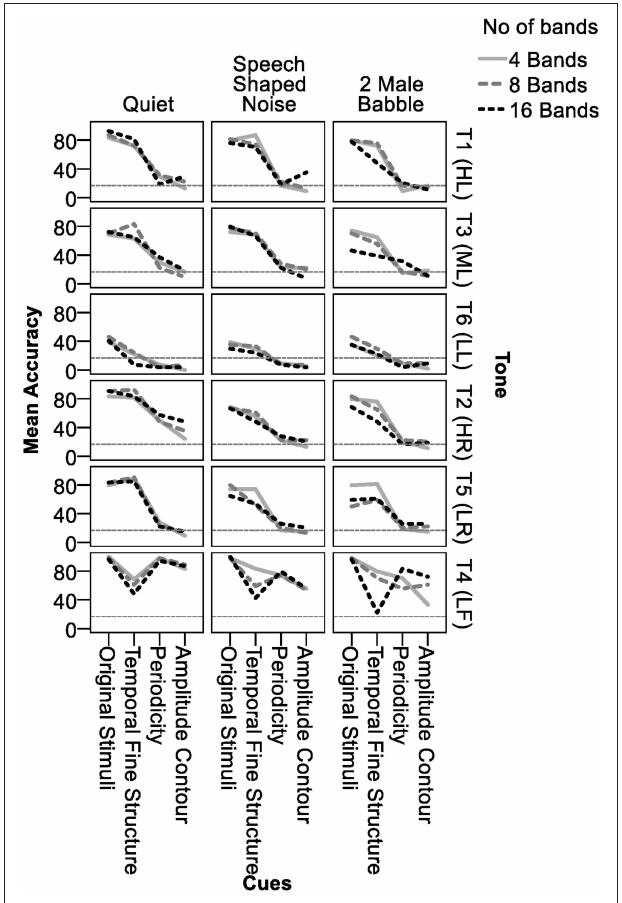
FIGURE 1 | Tone accuracy in different temporal cues, number of frequency bands and backgrounds. The horizontal broken line indicates chance level.